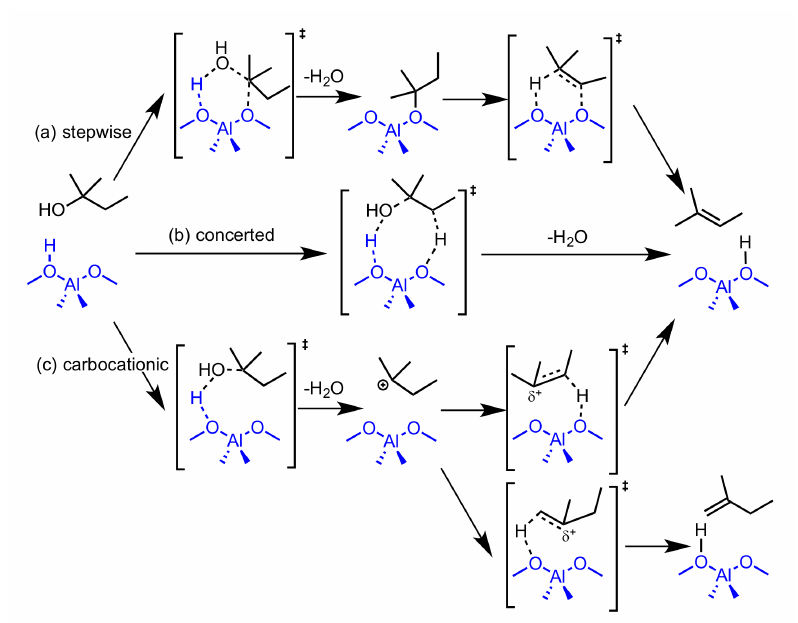
Figure 1. Posited ( a ) stepwise, ( b ) concerted, and ( c ) carbocationic mechanisms for tert-amyl alcohol (TAA) dehydration over a zeolite (e.g.,